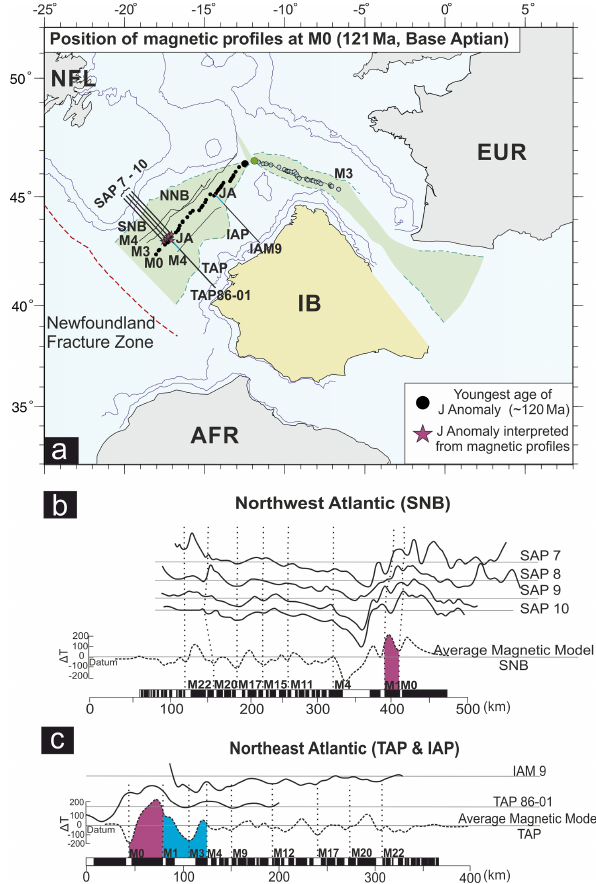
Figure 3. (a) Location of magnetic profiles across the Southern Newfoundland Basin and conjugate Tagus Abyssal Plain shown in (b) and (c) respectively. (b) Four along-track magnetic anomaly profiles (solid black lines) from the SNB, shown alongside a syn- thetic anomaly isochron model for comparison (dashed line). Pink shading marks the high-amplitude J Anomaly, identified as M0–M1 by Rabinowitz et al. (1978). (c) Two along-track magnetic anomaly profiles (solid black lines) from the TAP, shown alongside a syn- thetic anomaly isochron model for comparison (dashed line). Pink and blue shading indicate the high-amplitude J Anomaly, identi- fied as M0–M4 by Whitmarsh and Miles (1995). Panels (b) and (c) adapted from Srivastava et al. (2000). IAP – Iberian Abyssal Plain; JA – J Anomaly; NNB – Northern Newfoundland Basin; SNB – Southern Newfoundland Basin; TAP – Tagus Abyssal